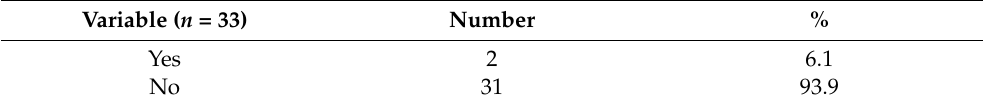
Table 11. Distribution of partnerships according to use of evaluation methodology.